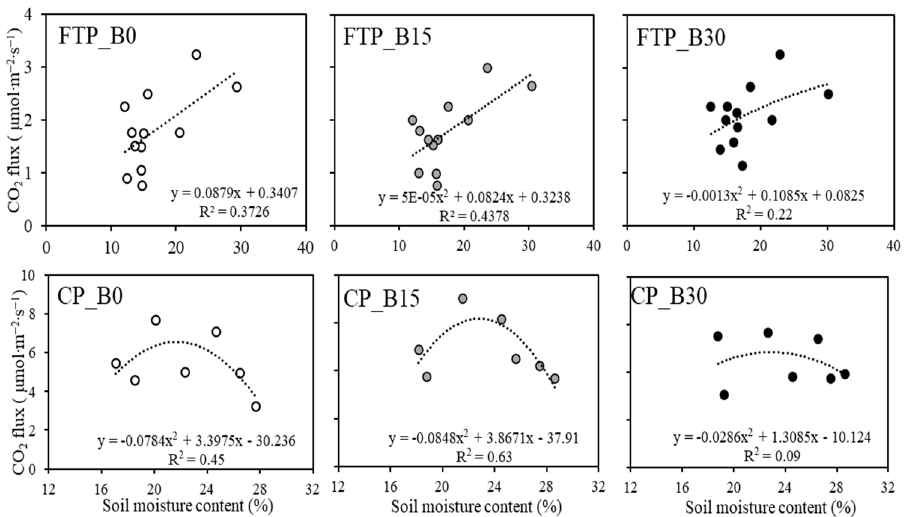
Figure 6. Relationship between soil respiration rate and soil moisture content for different biochar additions.